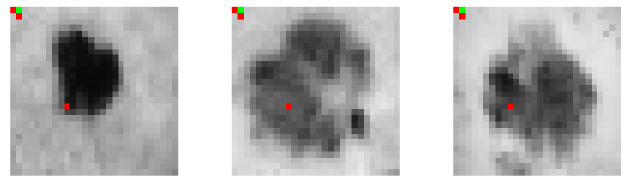
Figure 20. Samples belonging to the “benign” class, activating the same rule.